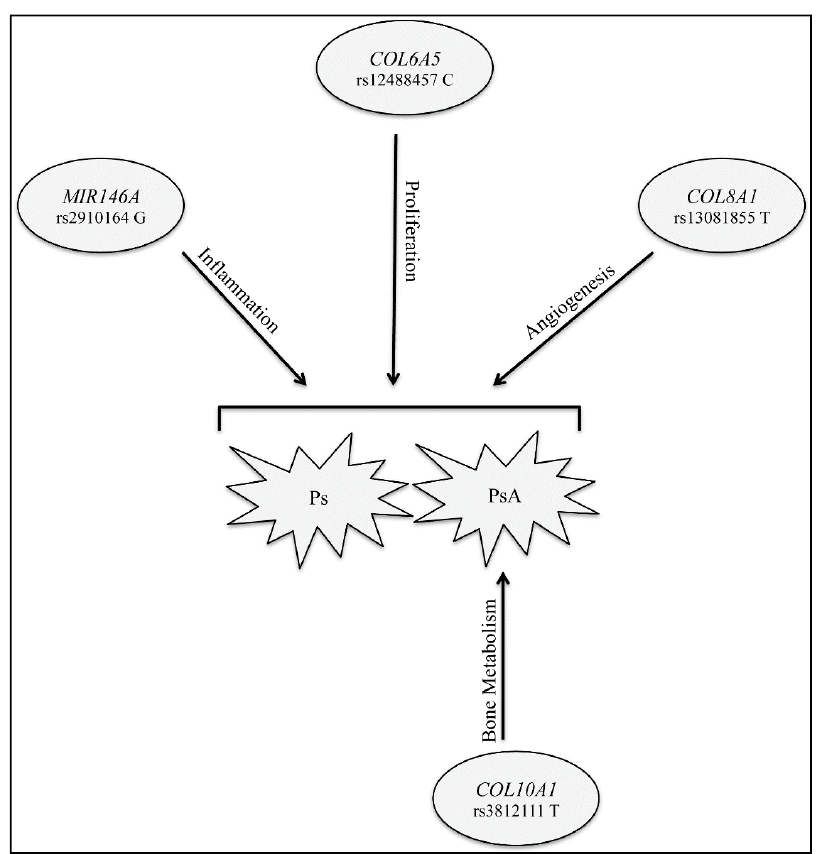
Figure 3. MIR146A, COL6A5, COL8A1 contribute to the susceptibility to both Ps and PsA, with an effect on the inflammation, proliferation and angiogenesis processes, respectively. COL10A1 is involved in the etiopathogenesis of PsA through its role in bone metabolism.